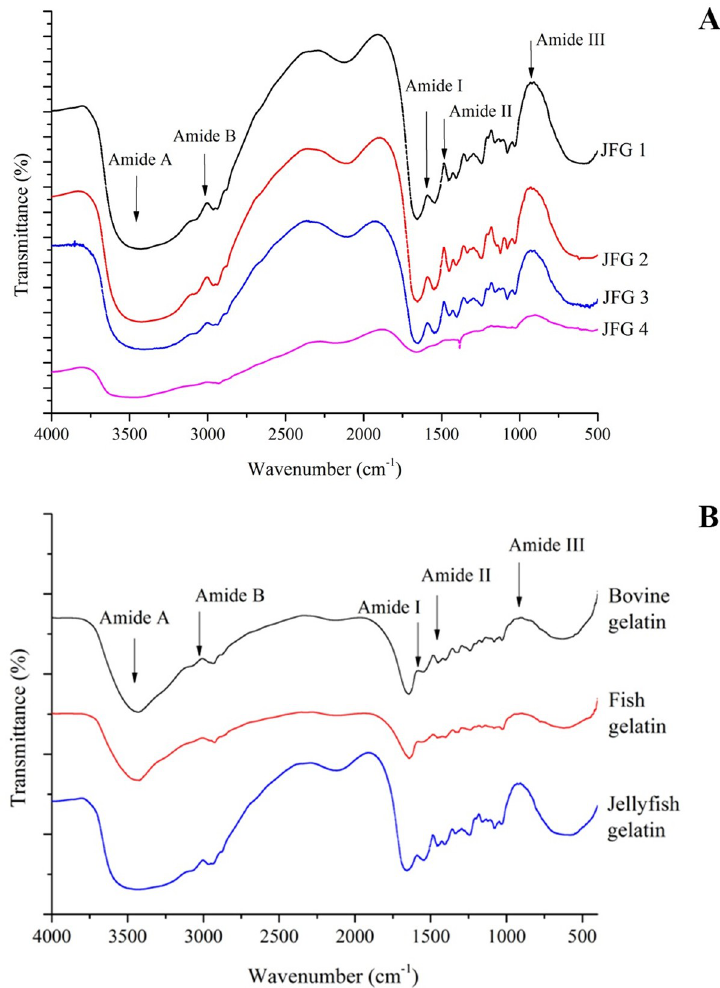
Fig 3. Fourier transform infrared spectra of gelatin. (A) JFG1-JFG4; with different hydrochloric acid and duration times conditions, (B) jellyfish gelatin (JFG1), bovine gelatin and fish